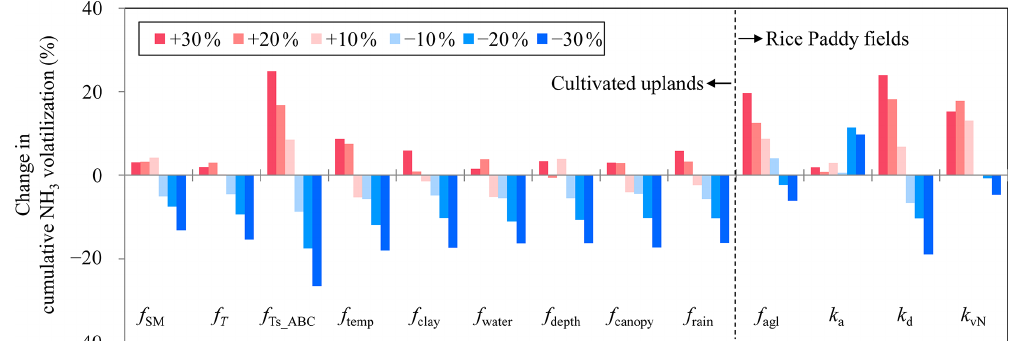
Figure 8. Sensitivity analysis on the improved parameters of the modified CNMM–DNDC model in simulating cumulative ammonia (NH 3 ) volatilization from cultivated uplands and rice paddy fields. The improved parameters for simulating NH 3 volatilization from cultivated uplands involved in the sensitivity analysis include effect of soil moisture and soil temperature on urea hydrolysis ( f SM and f T ); effect of soil temperature on ammonium bicarbonate decomposition ( f Ts_ABC ); and effect of soil temperature, soil clay content, soil moisture, soil depth, dry canopy, rain wetting canopy on NH 3 volatilization ( f temp , f clay , f water , f depth , f canopy , and f rain ). The improved parameters for simulating NH 3 volatilization from rice paddy fields involved in the sensitivity analysis include the effect of algal growth on floodwater pH ( f alg ), the dissociation and association rate constants for NH + –NH 3 ( aq ) equilibrium ( k d and k a ), and the volatilization rate constant of 4 NH 3 ( aq ) ( k vN